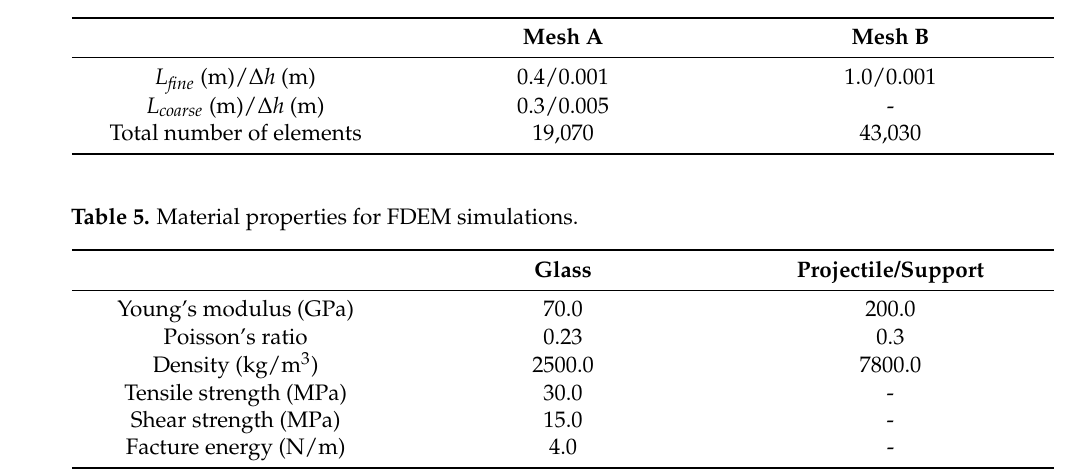
Figure 11. Glass impact configurations. Table 4. Element details of Mesh A and B.